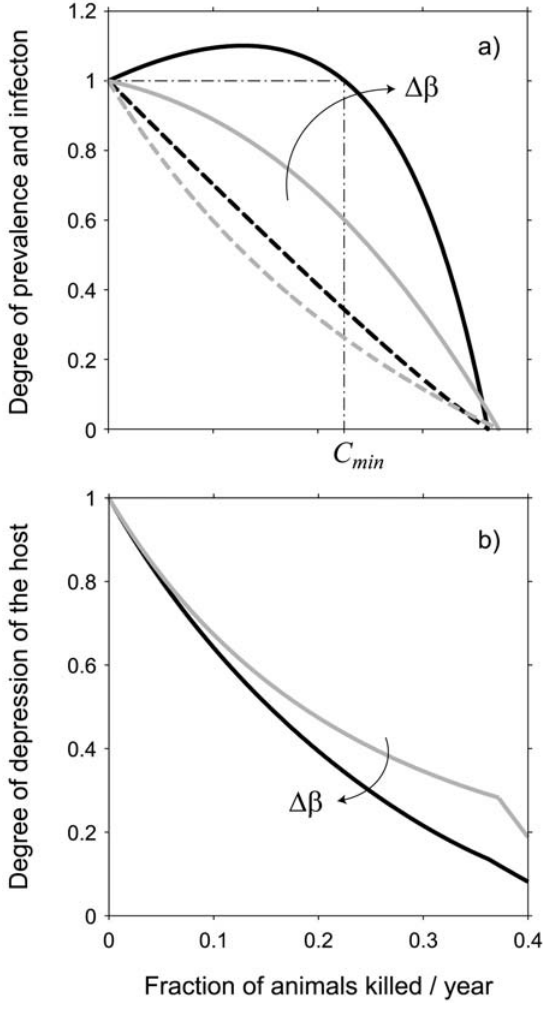
Figure 1. Effects of age/stage transmission on culling. a) Solid lines represent disease prevalence as function of the fraction of animals killed through culling scaled with respect to prevalence at equilibrium in the absence of culling; dotted lines refer to the number of infected individuals as functions of of the fraction of animals killed through culling scaled with respect to prevalence at equilibrium in the absence of culling; gray lines Db = 0 ( b a = b j = 0.2856); black lines Db = b a 2 b j =0.31 ( b a =0.32; b j =0.01). In both cases R 0 =9.-b) Degree of depression of population abundance as a function of culling rate c under the same condition than above. Other parameter values have been set as follows: n =1.25 years 2 1 , m j =0.9 years 2 1 , m a =0.4 years 2 1 , c = 0.0067 ( # individual 2 1 * 220 km 2 * years 2 1 ), a = 25 years 2 1 , r =2 years 2 1 , d =17.4 years 2 1 .